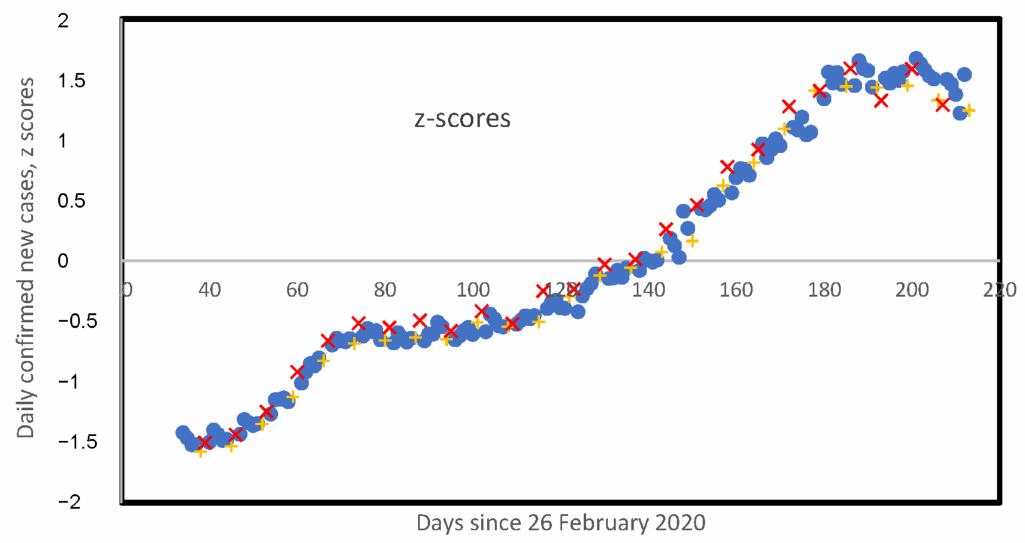
Figure 8. Z-transformed scores of confirmed world daily new cases [30], from Figure 6, as a function of days since 26 February 2020 until 23 August 2020 + indicates Sundays, X indicates Mondays. Z-transformations are specific to each